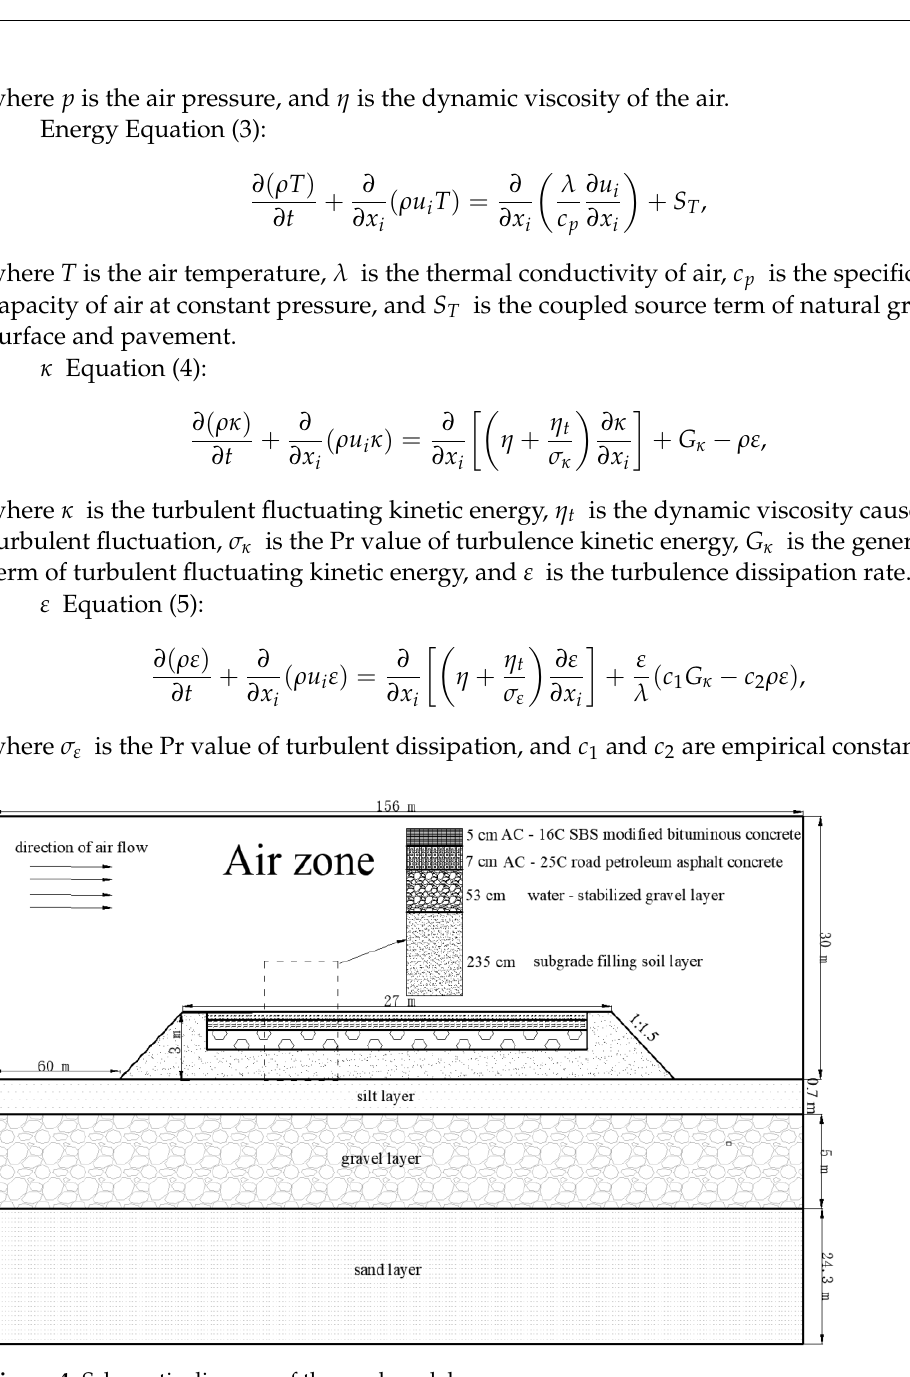
Figure 4. Schematic diagram of the road model.